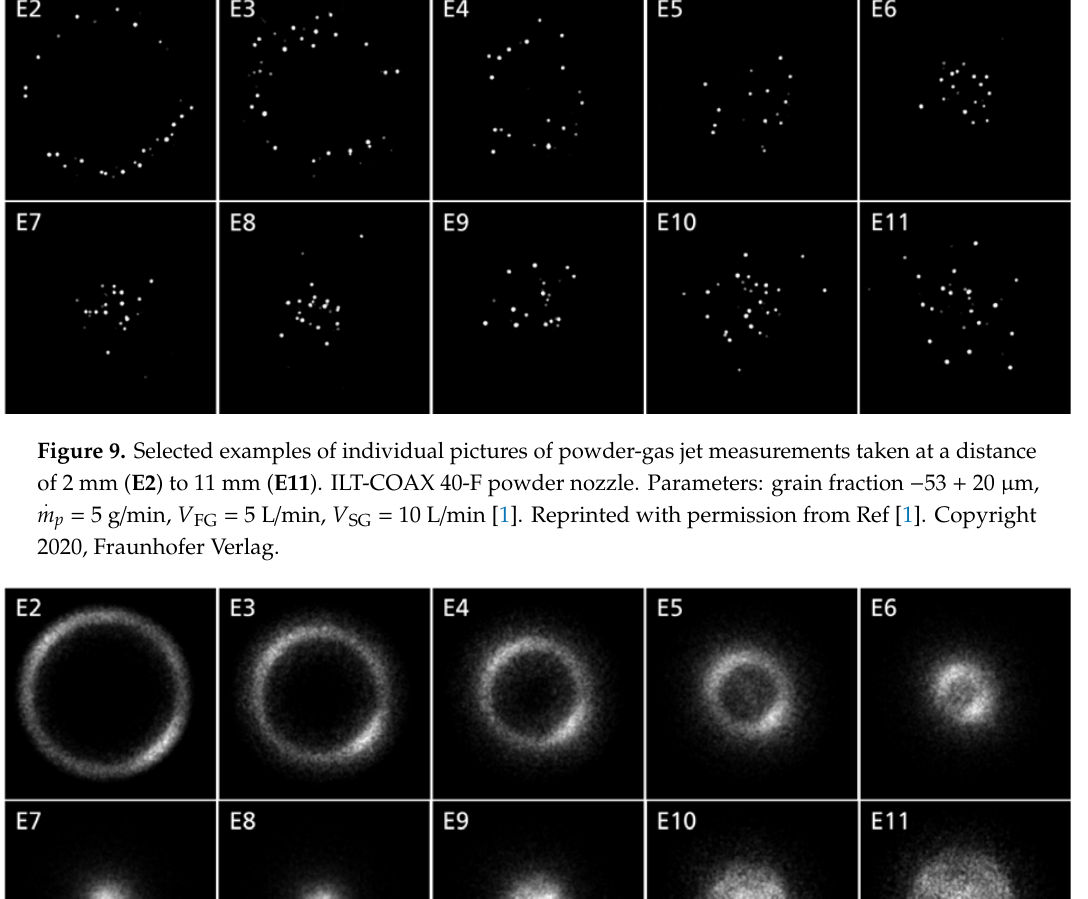
Figure 10. 3000 superimposed images, each of powder-gas jet measurements taken at a distance of 2 mm (E2) to 11 mm (E11). ILT-COAX 40-F powder nozzle. Parameters: grain fraction -53 + 20 µm,